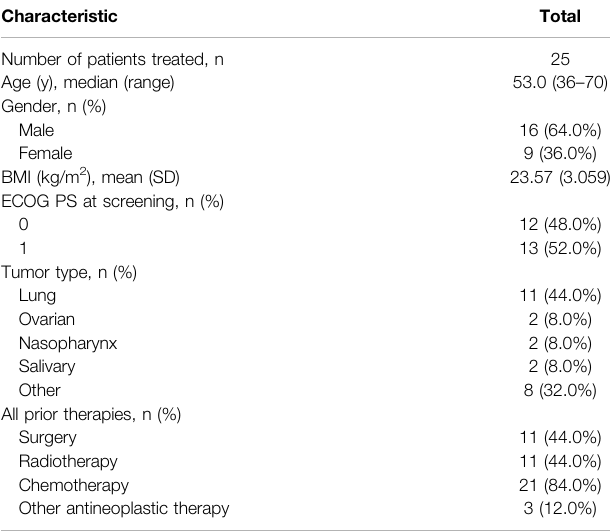
TABLE 1 | Summary of baseline demographic